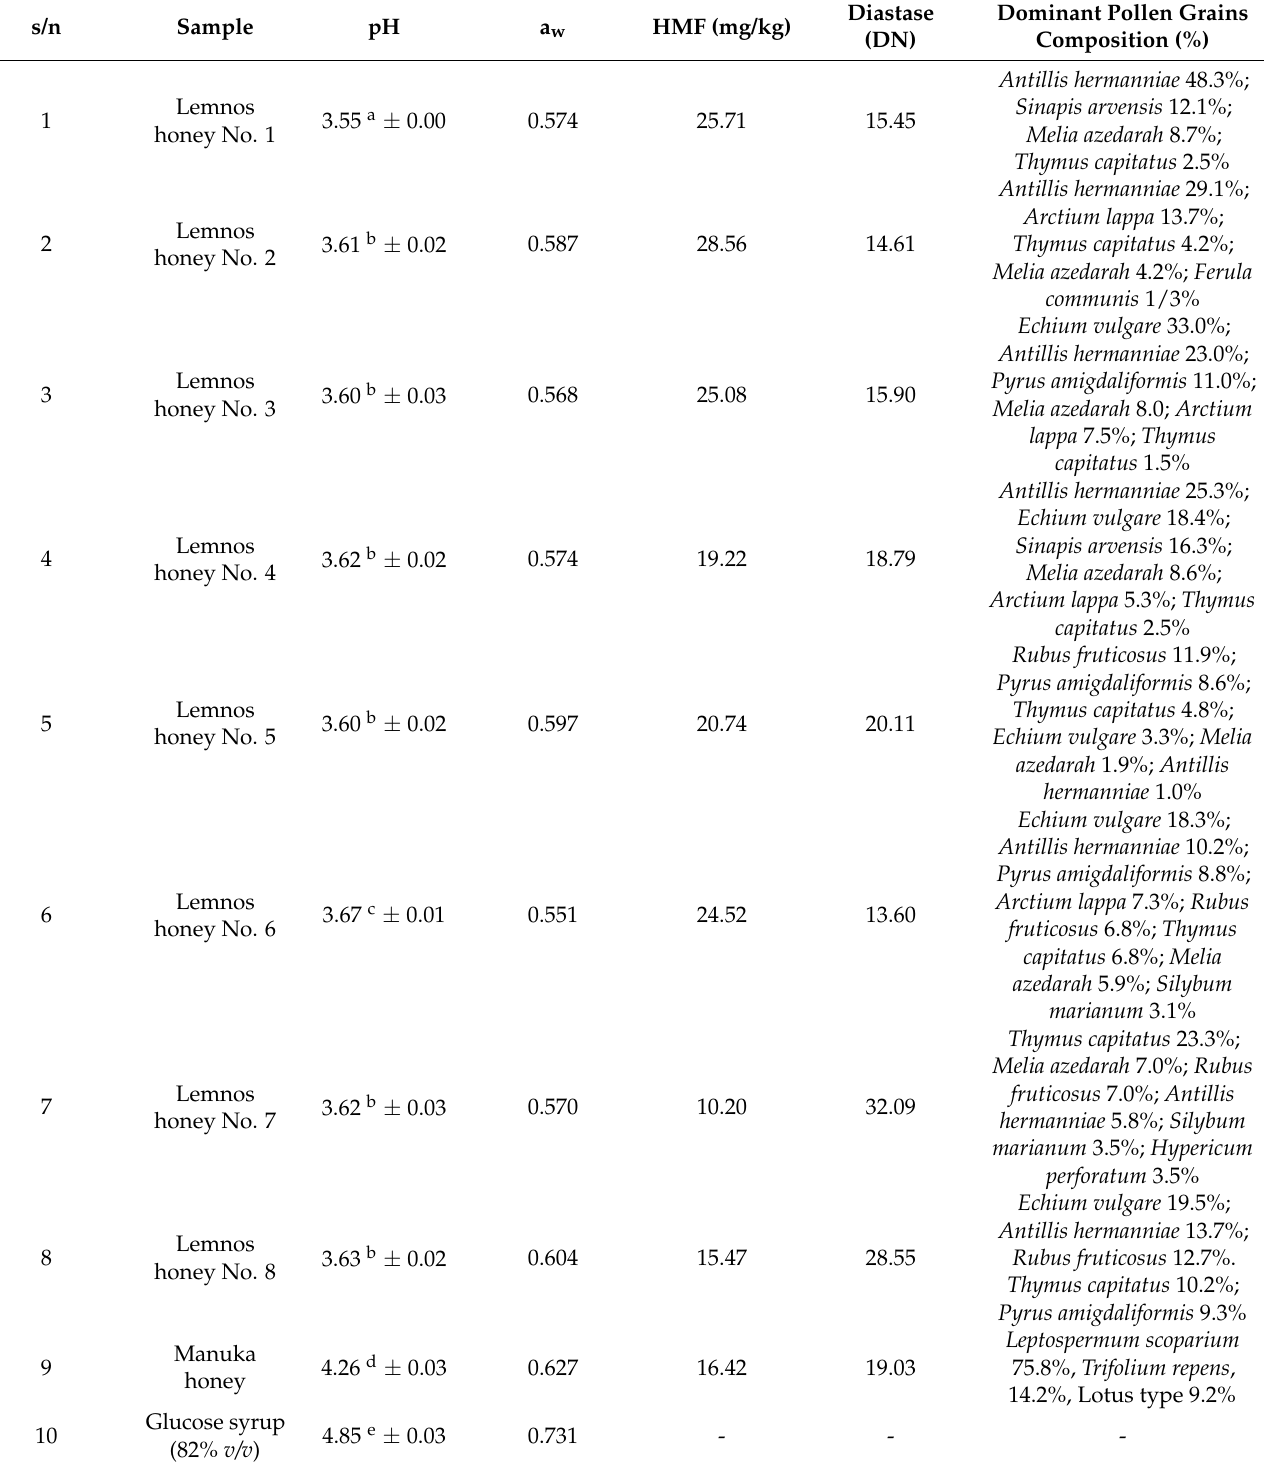
Table 3. pH, a w , HMF (mg/kg), diastase (DN) and pollen composition (%) of each honey. The pH and a w of glucose syrup (82% v/v ) are also indicated. For pH, mean values ( n = 3) sharing at least one common superscript letter are not significantly different ( p >